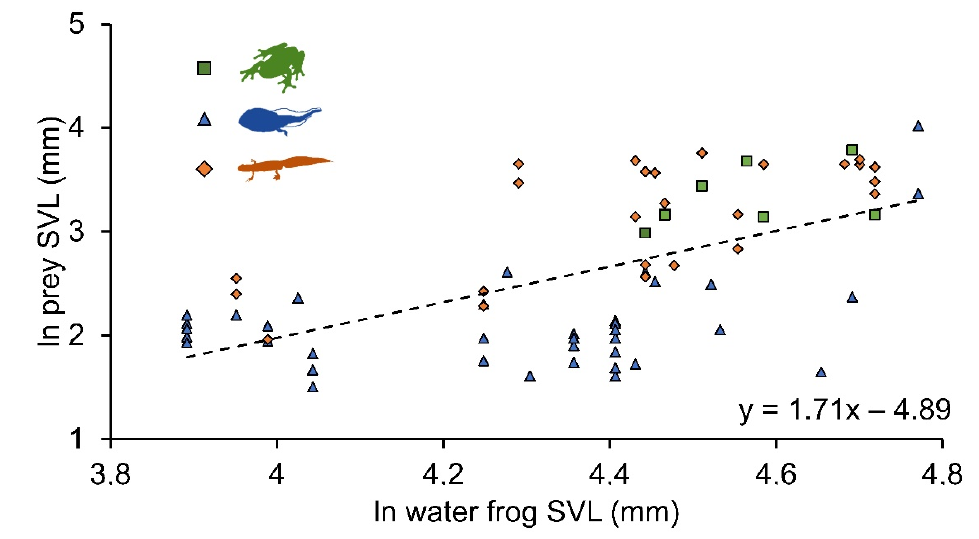
Figure 5. Size-selective predation: Size of consumed amphibians as a function of size of Pelophylax water frog. SVL: snout-vent length. Green squares: metamorphosed anurans; blue triangles: tadpoles; orange diamonds: newts. Dotted line represents the linear regression between the SVL of marsh frogs and the SVL of ingested amphibians (y = 1.71x − 4.89).